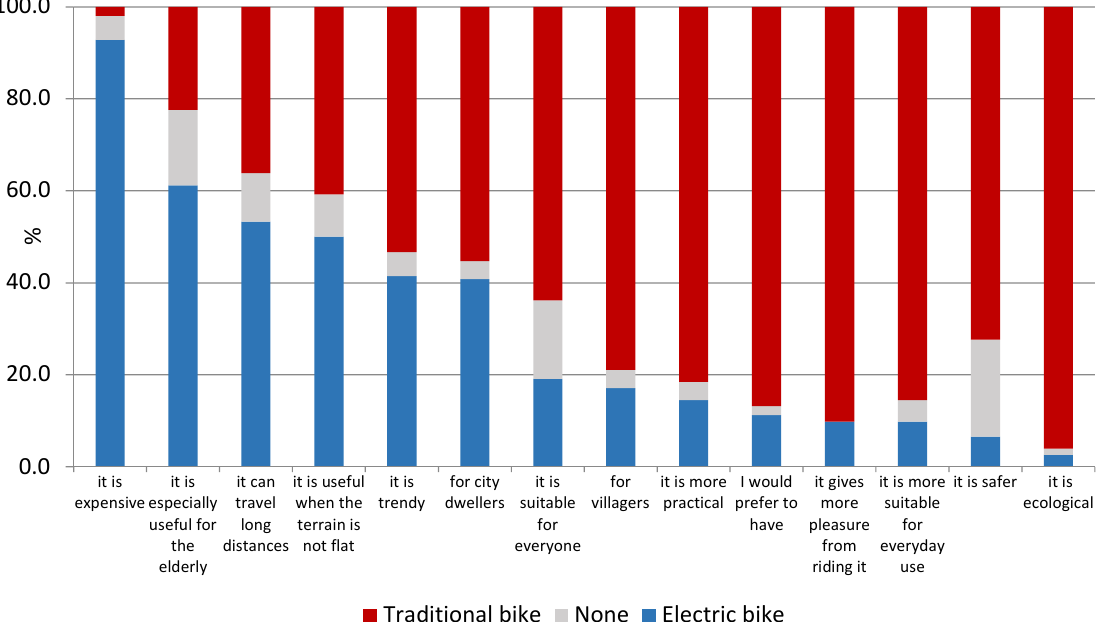
Figure 4. Structure of answers to the question: “Which of the options listed below best fits the characteristics indicated”. Source: Own elaboration on the basis of the questionnaire survey.